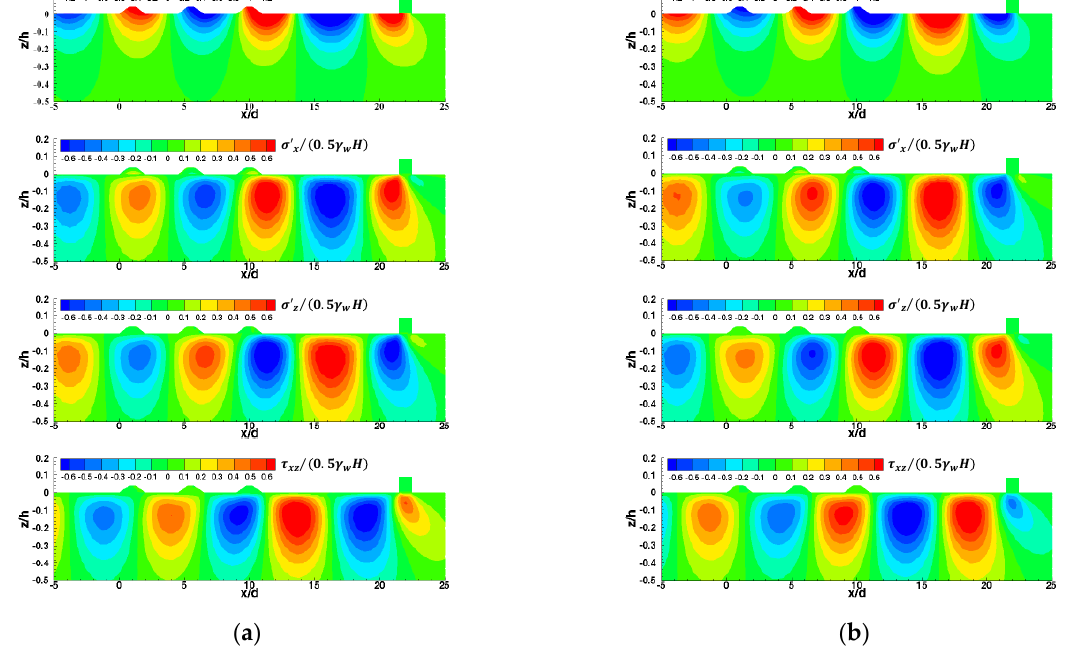
Figure 19. Distribution of the wave−induced dynamics of the seabed around the breakwaters (𝑚 = 3) with 𝑘𝑑 = 0.6 under Mode 2 (at 𝑆 𝐿⁄ = 1.0 ) ( a ) 𝑡 𝑇⁄ = 0.25 ; ( b ) 𝑡 𝑇⁄ = 0.75 . Figure 20 is the vertical distribution of the wave-induced pore pressure (0.5𝛾 𝐻)⁄ and the dynamic stresses for the various resonator lengths below the toe 𝑝 𝑚𝑎𝑥 𝑤 of the vertical breakwater (the leading edge of the vertical breakwater) for 𝑚 = 3 . The vertical distribution of the pore pressure and the effective stresses below the toe of the vertical breakwater also oscillate with an interval ∆𝑆 𝐿⁄ = 8 16⁄ cycle. Taking 𝑘𝑑 = 0.6 as an example, the pore pressure and the dynamic stresses decrease until 𝑆 𝐿⁄ = 12 16⁄ and then increase with the increase of the distance 𝑆 𝐿⁄ . Finally, the vertical distribution at 𝑆 𝐿⁄ = 16 16⁄ shows the same trend as that at 𝑆 𝐿⁄ = 8 16⁄ , which is in phase with the enhancement coefficient. This indicates that the resonator length 𝑆 𝐿⁄ is a key parameter for the protection of the rear structure or the seabed foundation. A left shift in Figure 20 is also shown. The maxima wave-induced pressure occurs at the resonator length 𝑆 𝐿⁄ = 16 16⁄ , 15 16,⁄ and 14 16,⁄ under different wave periods (𝑘𝑑 = 0.6 , 0.7, and 0.8) . With the greater detuning frequency, the re-reflection caused by the submerged breakwaters is too weak to affect the wave transformation. Consequently, the magnitude of the pore pres- sure and the dynamic stresses only show a slight oscillation (see 𝑘𝑑 = 0.8 ).